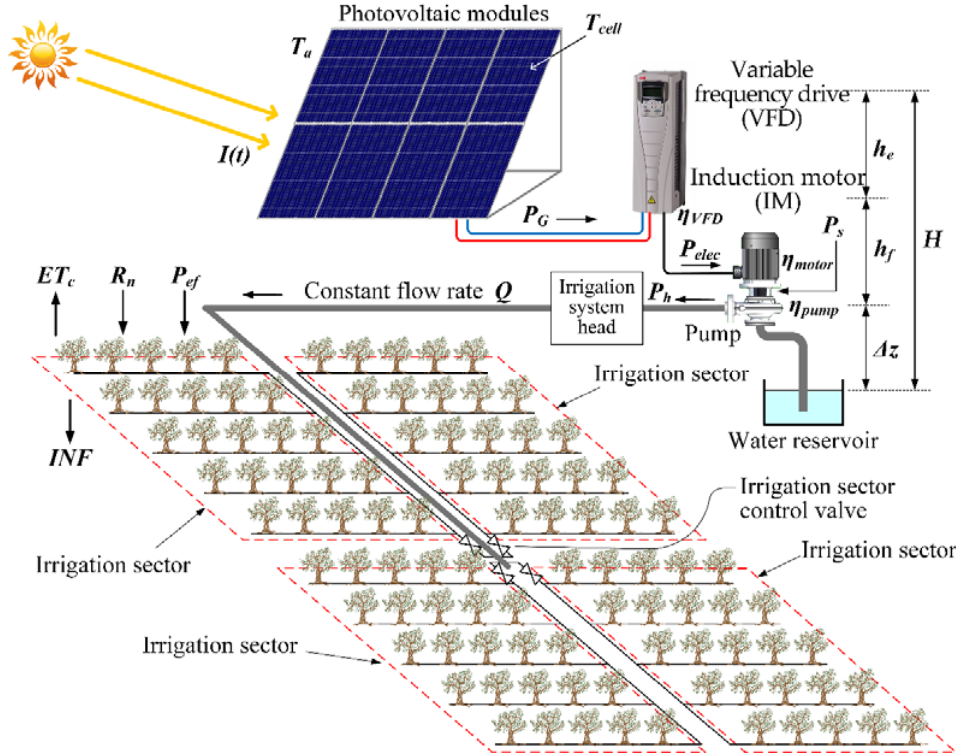
Figure 1. Scheme of the direct photovoltaic irrigation system.